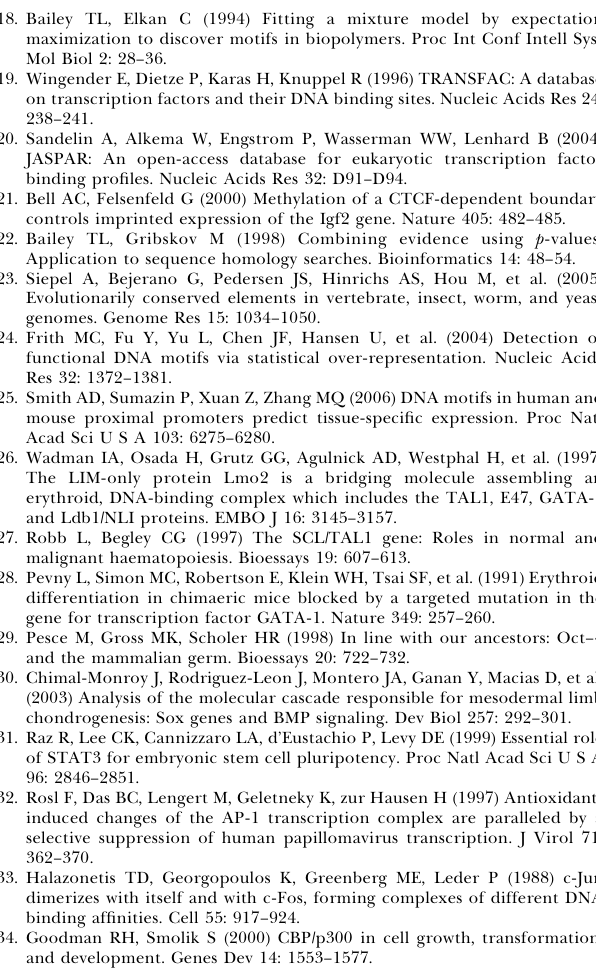
Figure S8. Cell Type–Specific DNaseI HS Sites Colocalize with Cell Type–Specific Histone Modifications (H3K4me1, H3K4me3, H3ac,